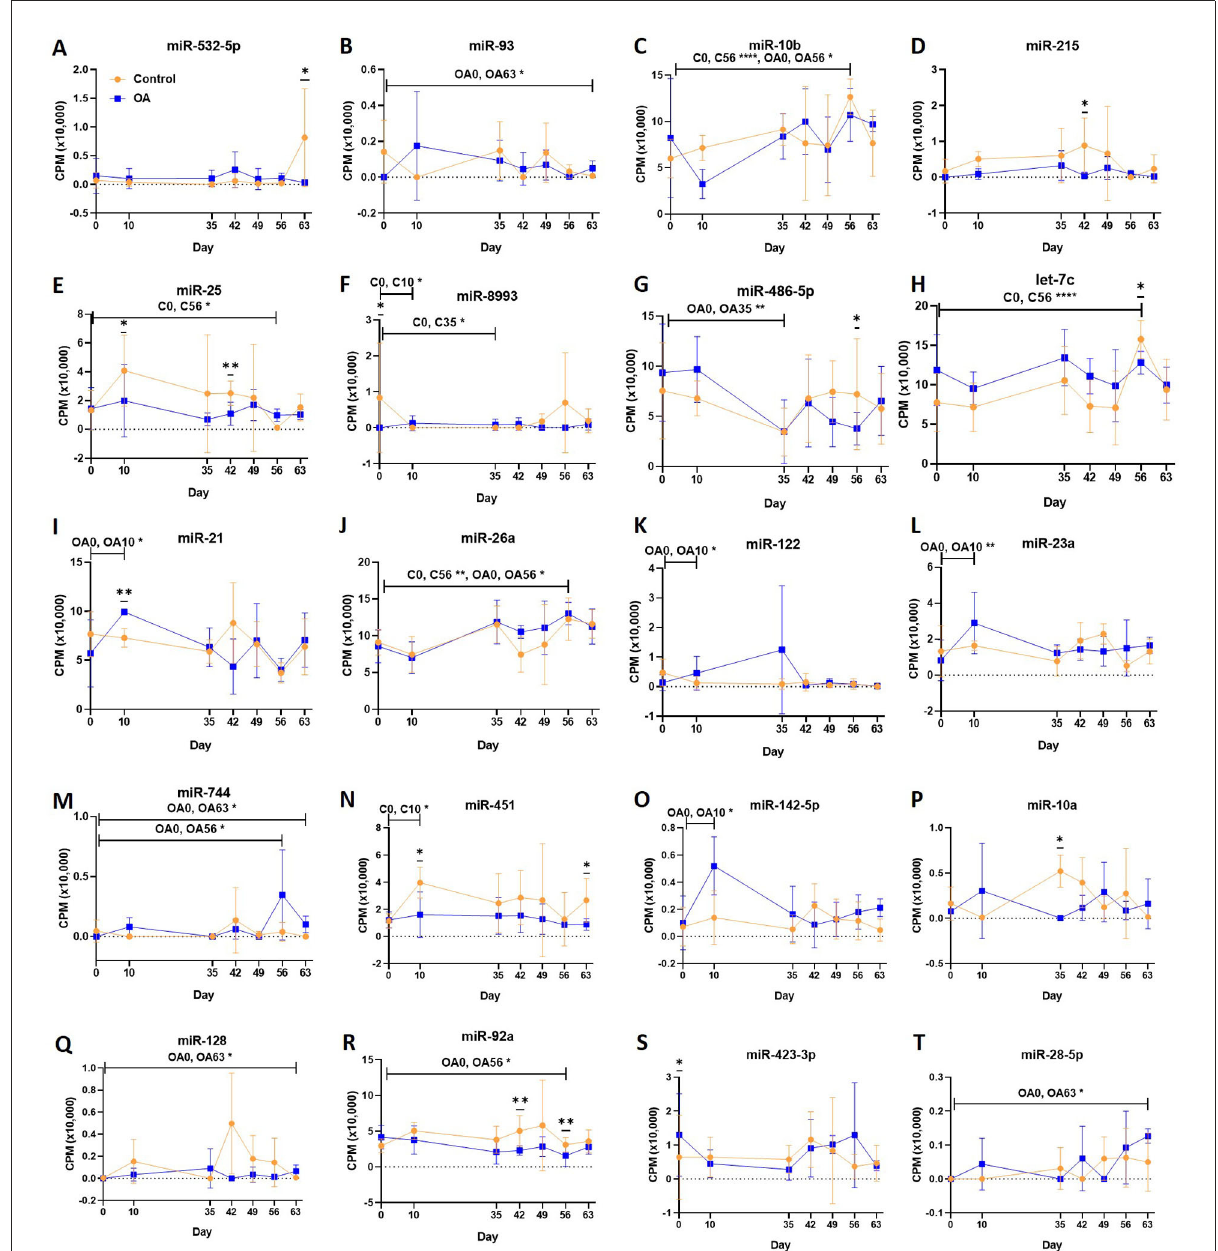
FIGURE6 (A–T) Differentially expressed miRNAs isolated from synovial fluid-derived extracellular vesicles following small RNA sequencing. Comparisons were made between control (C) and osteoarthritis (OA) and between OA time points (days 0, 10, 35, 42, 49, 56, and 63), miR; eca-miR, n = 4 horses. Individual panels for the 20 DE miRNAs altered between OA time points or between control and OA. Error bars ± 1 standard deviation. * p < 0.05, ** p < 0.01, and **** p <